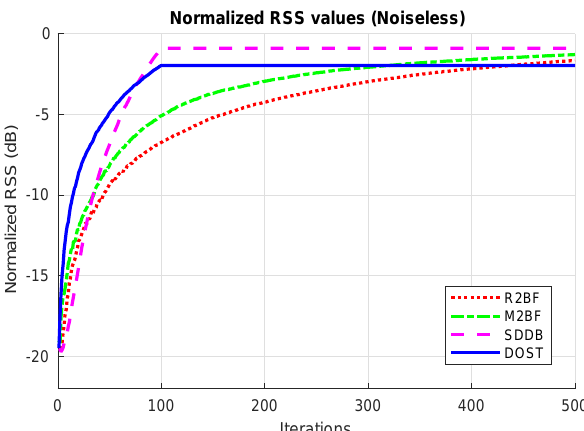
Figure 2. Evolution of the distributed beamforming gain in a noiseless setting for N = 100 nodes.